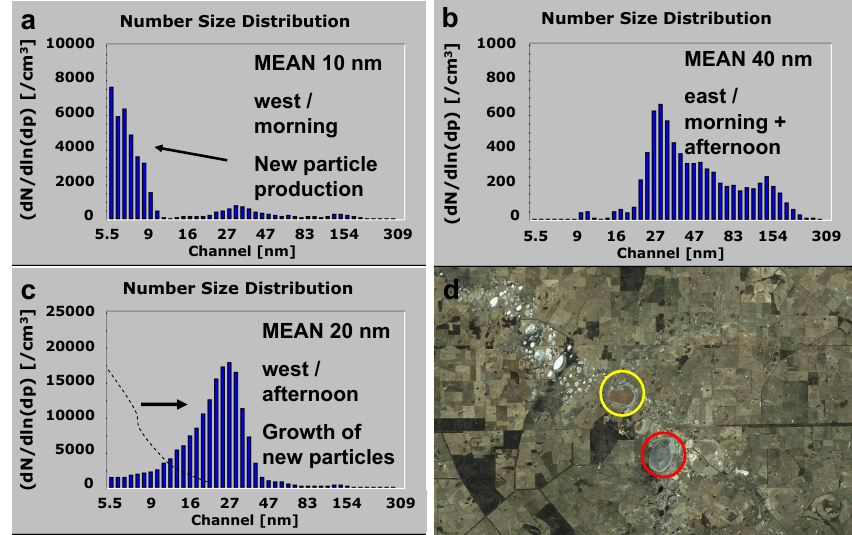
Fig. 3. Diurnal change of size distributions under calm conditions (wind speed below 2.5m/s). Nucleation mode particles were found only over the northern Lake (Lake Stubbs, yellow), not over the southern one (Lake Buchan, red). Note also the surface colours indicating different humidity. The white spots are smaller salt lakes (d) . Size distributions of the ultrafine particles over Lake Stubbs in the west during the main nucleation phase ( ∼ 11:00 a.m. local), (a) and three hours later after aging of the particles (c) . Size distribution in the east (b) without change between morning and afternoon. Note the different scales in the total numbers. The main fraction of the fresh nucleation mode particles at 02:00 p.m. local time were still smaller than cloud condensation nuclei sizes (50nm) but the CCN range was already affected.